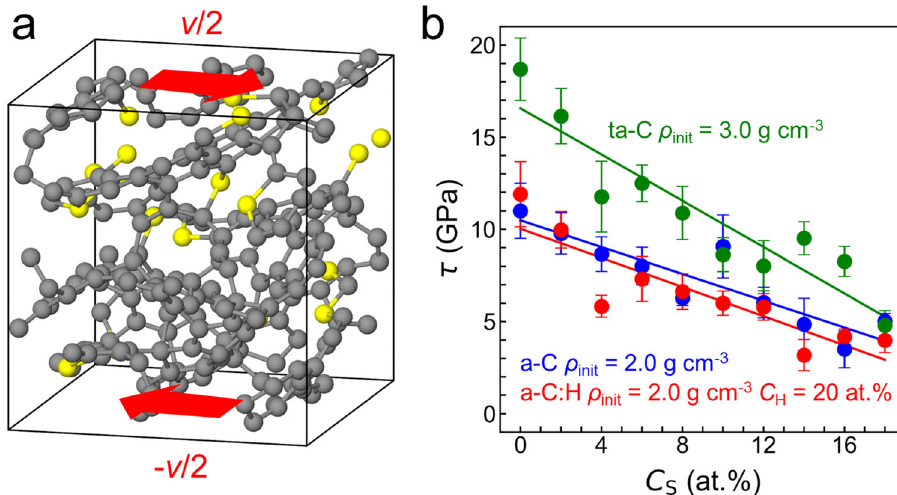
Fig. 5 DFTB3 quantum MD simulations of sulphur doped DLCs subject to homogeneous shear deformation. a Atomic con fi guration at t = 50 ps for a-C with an initial density of 2.0 g cm − 3 and 8 at% S. Carbon atoms are represented by grey and sulphur atoms by yellow spheres. A shear velocity of v = 100 m s − 1 is imposed along the x direction (as shown by red arrows) with Lees-Edwards boundary conditions. b Shear stresses τ as a function of the sulphur concentration C S in ta-C with an initial density ρ init = 3.0 g cm − 3 , in a-C with ρ init = 2.0 g cm − 3 , and in a-C:H with ρ init = 2.0 g cm − 3 and 20 at% hydrogen. τ is calculated every 10 ps and averaged for 50-ps MD runs. Error bars represent standard error of means.